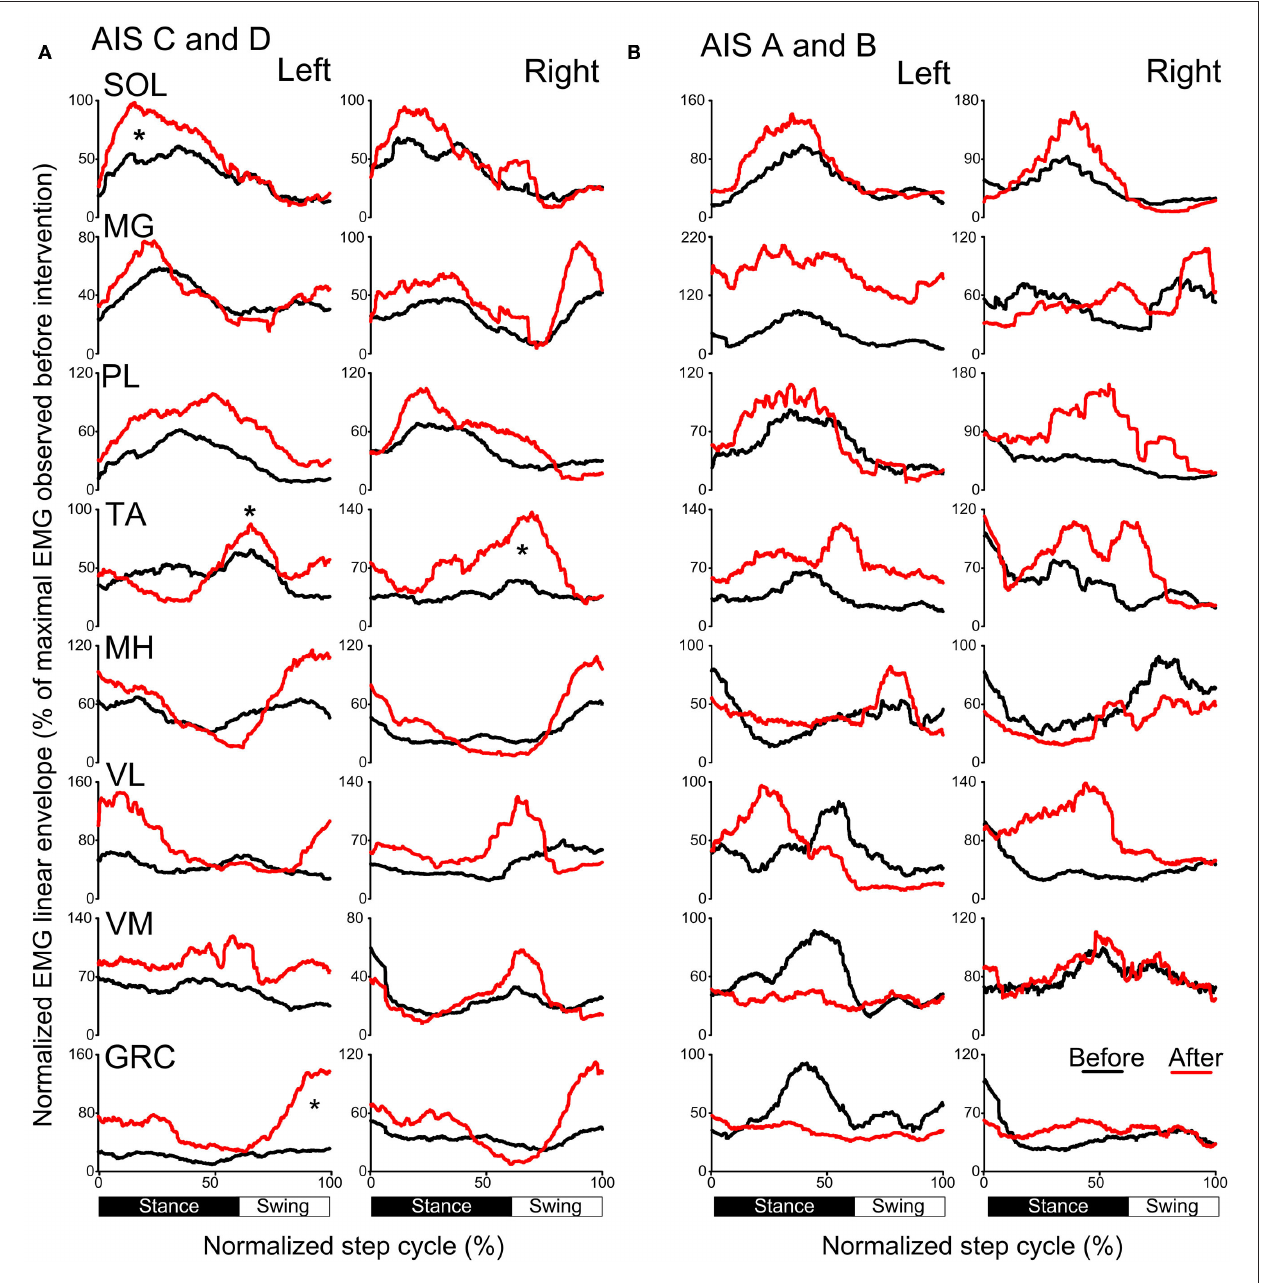
FIGURE 9 | Mean muscle activation pattern before and after transspinal-TMS PAS and locomotor training during assisted stepping. Left and right leg locomotor muscle EMG activity during stepping before (black lines) and after (red lines) transspinal-TMS PAS and locomotor training from participants with incomplete (A) and complete SCI (B) . EMG is normalized to the maximal homologous EMG obtained during stepping before training. Heel strike is at zero normalized gait cycle. EMG, electromyographic; GRC, gracilis; MH, medial hamstrings; MG, medialis gastrocnemius; PAS, paired associative stimulation; PL, peroneus longus; SOL, soleus; TA, tibialis anterior; TMS, transcranial magnetic stimulation; VL, vastus lateralis; VM, vastus medialis. * p < 0.05.